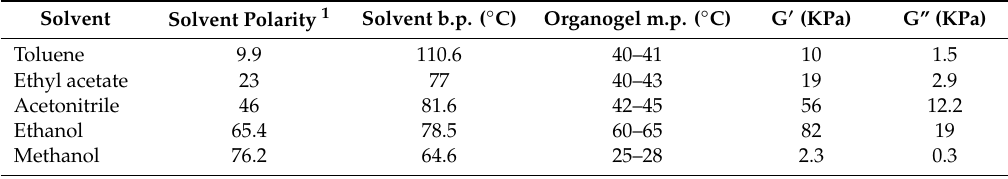
Table 1. Summary of the conditions for organogel formation using gelators A in di ff erent solvents (all measurements were done in